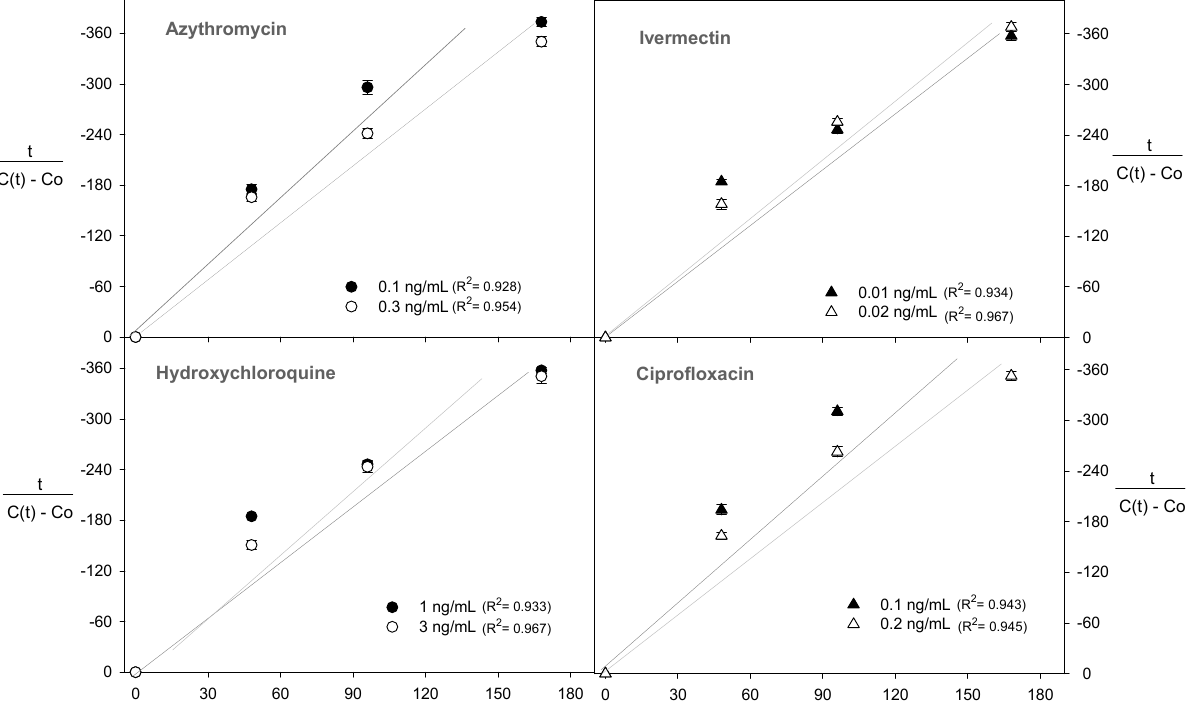
Figure 5. Peleg’s model linearisation of the total monomeric anthocyanin content, where t corresponds with the time (min), C(t) is the concentration of anthocyanin at time t, and C 0 is the concentration of anthocyanin at zero time.